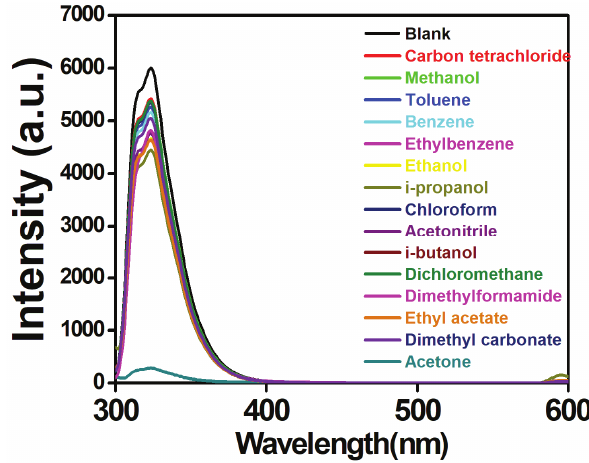
Figure 3. Fluorescence spectra of complex {[Zn(bipy) 2 (H 2 O)](ClO 4 ) 2 } ( 1 )dissolved in DMSO (blank) and upon the addition of di ff erent organic solvents.